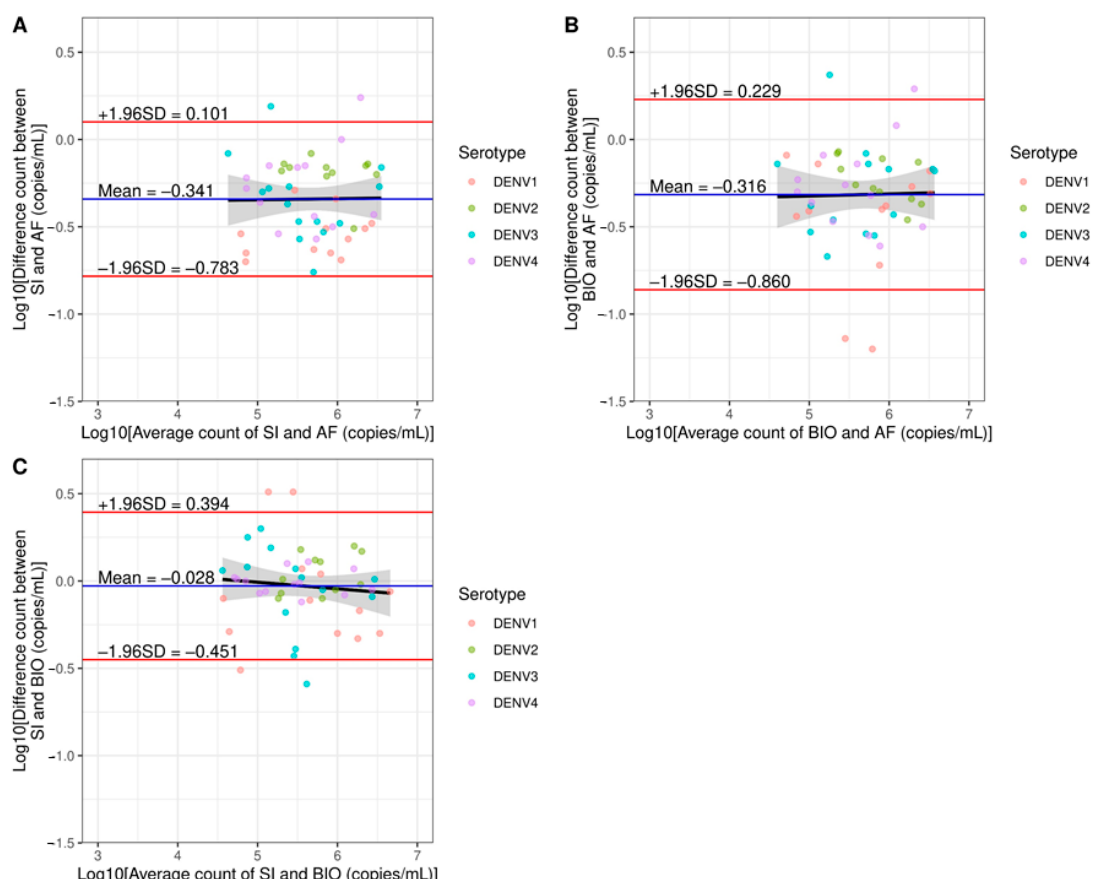
Figure 6. Bland–Altman plots for interlaboratory variations. Bland–Altman plots of RT-ddPCR results between two laboratories: ( A ) SI versus AFRIMS (AF), ( B ) BIOTEC (BIO) versus AFRIMS (AF), and ( C ) SI versus BIOTEC (BIO) with LOQ filtering. The horizontal black dashed lines represent agreement lines. The horizontal blue lines show mean differences between the two methods (bias). The horizontal red lines show agreement limits.